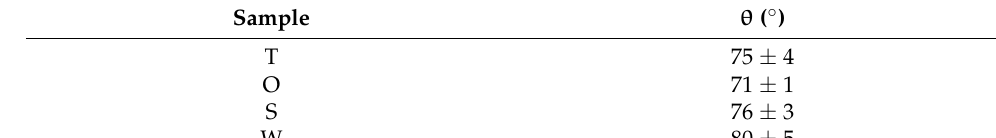
Table 3. Contact angle measurements ( θ ).